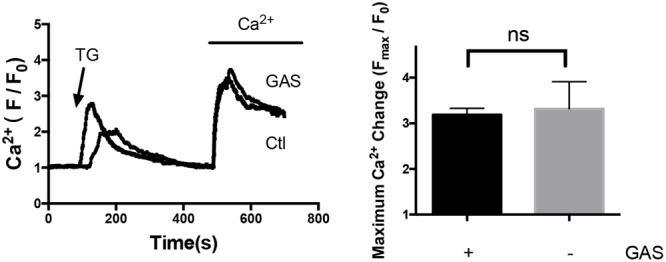
Lack of acute gastrodin action on SOCE in phenylephrine-treated hypertrophic cardiomyocytes. Shown are representative immunoblot images (left) and data summary (right). The phenylephrine-treated (50 μmol/L, 48 h) hypertrophic cardiomyocytes were first challenged with 4 μmol/L TG in a Ca2+-free bath, which induced the first Ca2+ rise, followed by adding back 1 mmol/L Ca2+ to the bath, which induced the second Ca2+ rise. The second Ca2+ rise is due to SOCE. Only SOCE is plotted in the summary chart. When appropriate, 100 μmol/L gastrodin was applied 5 min before TG. The data are expressed as the mean ± SEM (n = 5 repeats, >15 cells per repeat). ns, not significant.